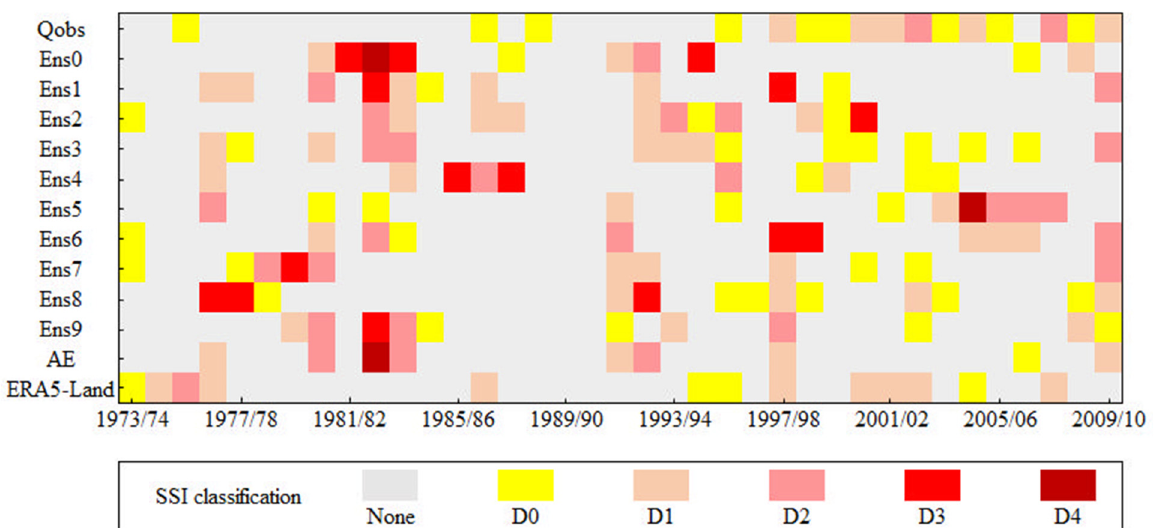
Figure 4. SSI classification for the observed (Qobs) and simulated streamflow with the ten ERA-20CM ensemble members, the AE, and the ERA5-Land from 1973/74 to 2009/10 for the PRB, where D0 is “abnormally dry”, D1 is “moderate drought”, D2 is “severe drought”, D3 is “extreme drought”, and D4 is “exceptional drought”.